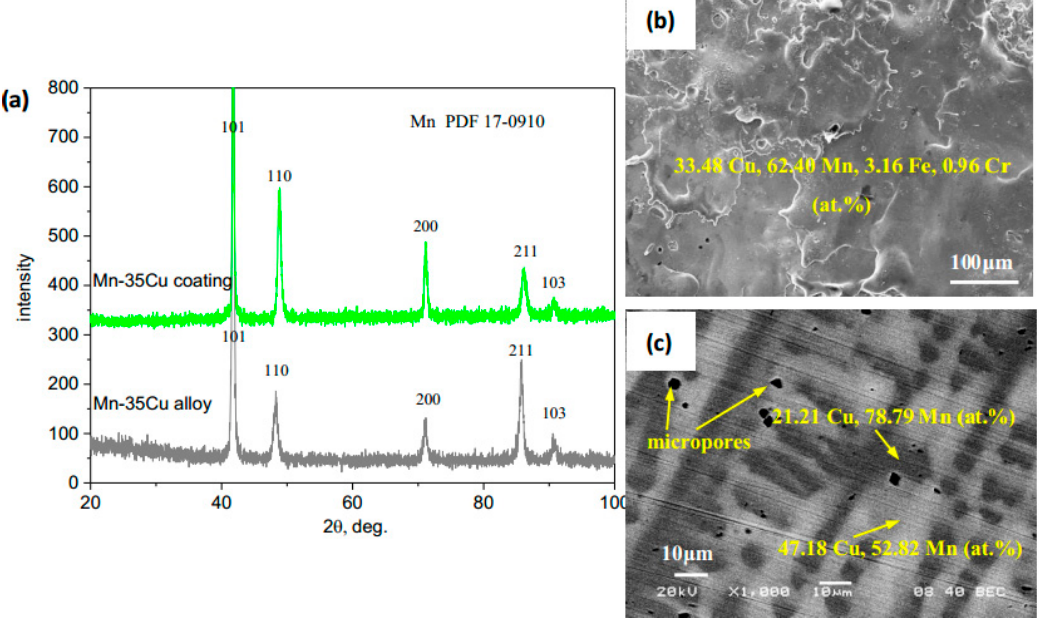
Figure 1. X-ray diffraction (XRD) ( a ) and scanning electron microscopy (SEM) morphology of Mn-35Cu alloy and Mn-35Cu coating on 430 SS by high-energy micro-arc alloying process (HEMAA); ( b ) Mn-35Cu coating, ( c ) Mn-35Cu alloy.